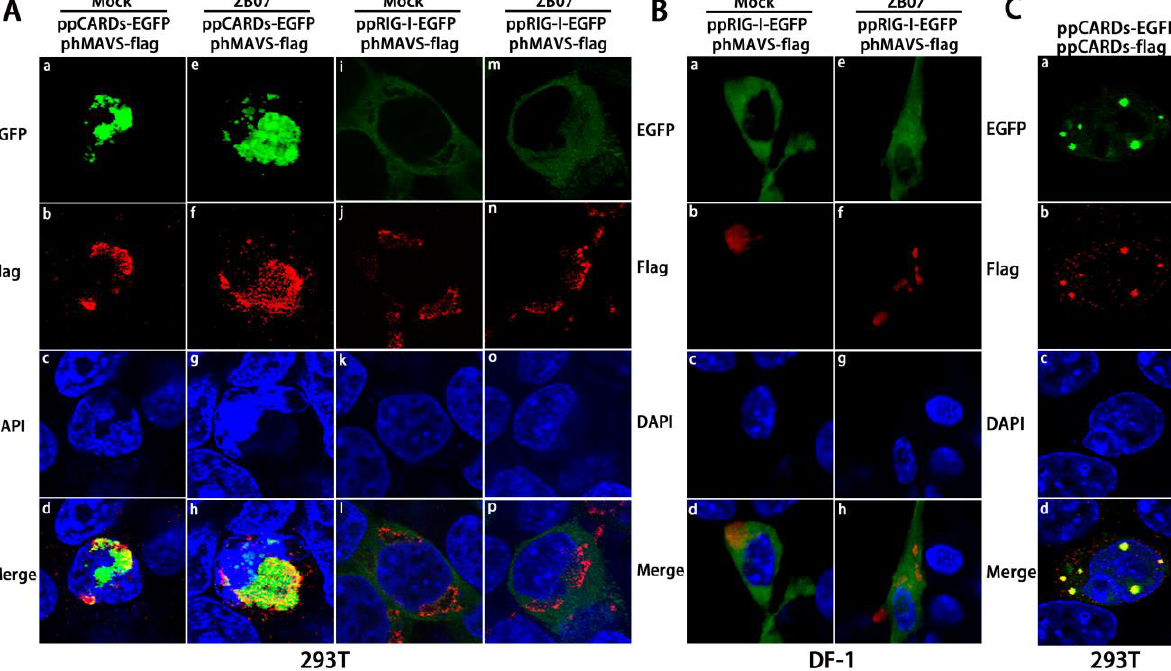
Figure 4. Co-localization of pigeon CARDs with MAVS ( A ) phMAVS-flag and ppRIG-I-EGFP/ppCARDs-EGFP were co-transfected into 293T cells respectively, and 24 h later, transfected cells were infected with ZB07 viruses or mock-treated, then, transfected cells were dyed with anti-flag-antibody and DAPI at 8 h p.i. Then, the cellular localization of pRIG-I, CARDs, and hMAVS was examined via confocal microscopy; ( B ) pcMAVS-flag and ppRIG-I-EGFP were co-transfected into DF-1 cells respectively, and 24 h later, transfected cells were infected with ZB07 viruses or mock-treated, then, transfected cells were dyed with anti-flag antibody and DAPI at 8 h p.i. Then, the cellular localization of pRIG-I and hMAVS was examined via confocal microscopy; ( C ) 293T cells were co-transfected with ppCARDs-EGFP and ppCARDs-flag. 24 h later, transfected cells were dyed with DAPI, anti-flag antibody, and cy3 labled secondary antibody. Then, the cellular localization of pCARDs-EGFP and CARDs-flag was examined via confocal microscopy.